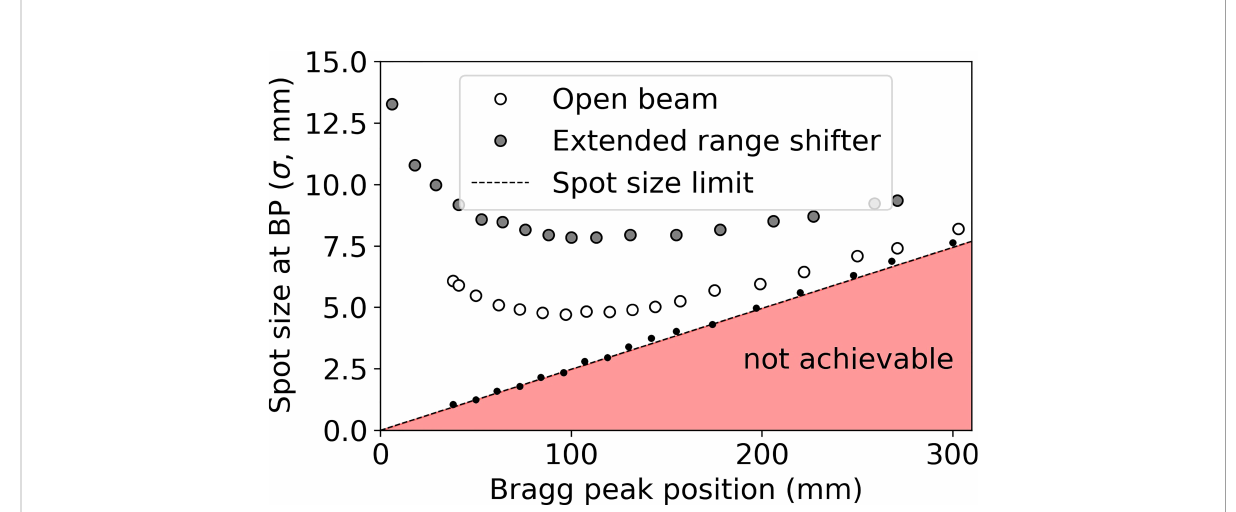
FIGURE 4 Spot sizes ( s ) obtained in water under three conditions: in fi nitesimal beamlet (black dots, dotted line), open beam (no beam-modi fi cation devices beyond the exit of the nozzle, white dots with black outline), and including a 45 mm WET range shifter at the extended position 30 cm upstream of isocenter (ERS, gray dots with black